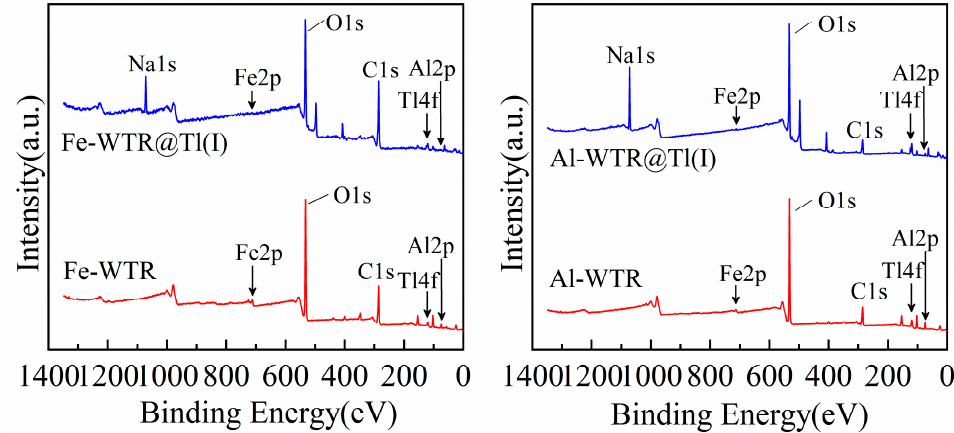
Figure 9. XPS spectra of Al-WTR and Fe-WTR before and after adsorption.